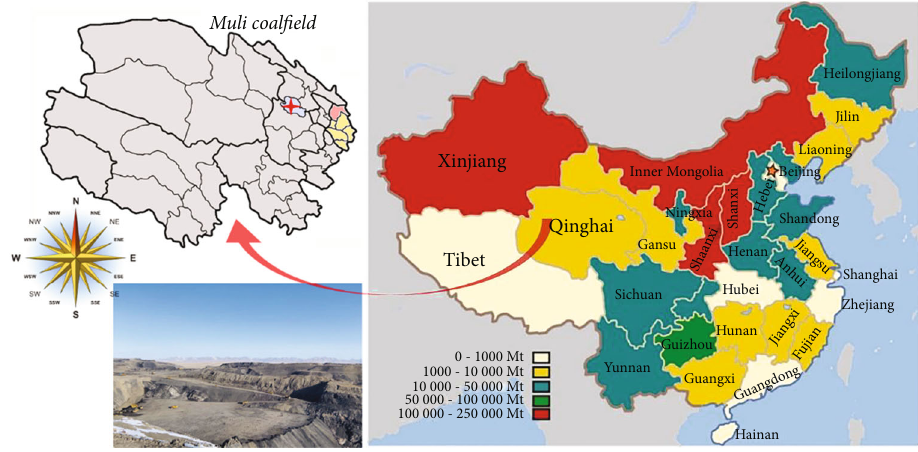
Figure 5: Illustration of the location of the Muli coal fi